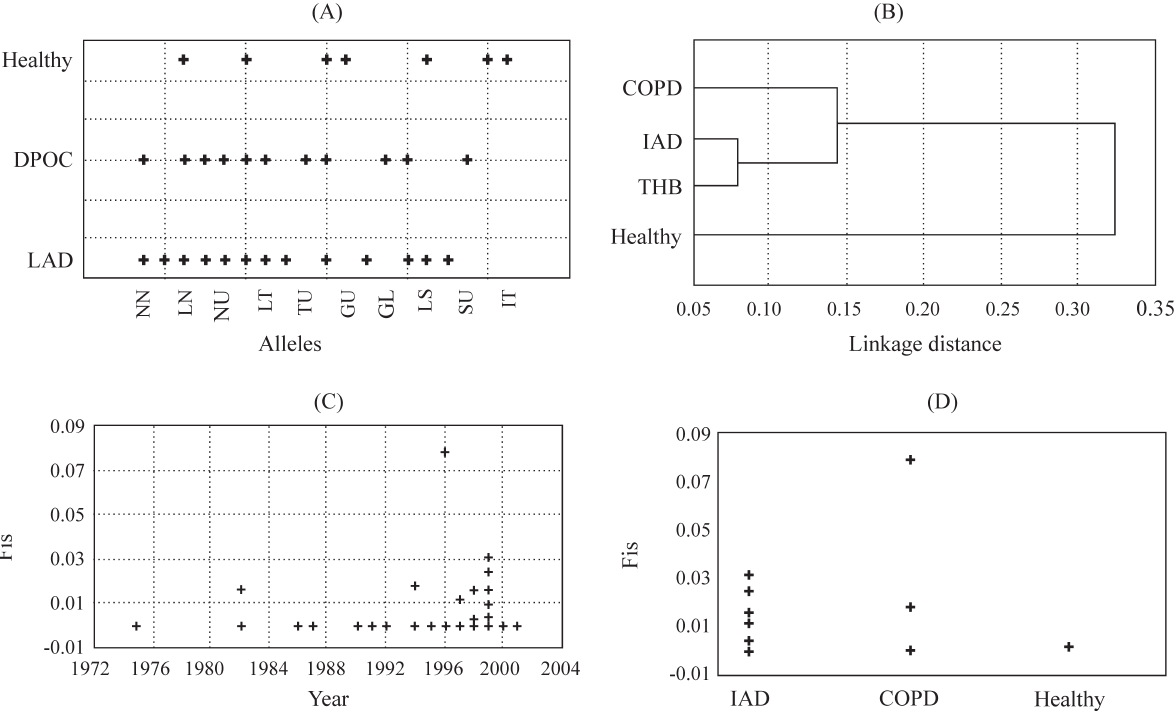
Figure 1 - (A) PI genotype distribution in thoroughbreds with chronic obstructive pulmonary disease (COPD), inflammatory airway disease (IAD) and healthy control horses (Healthy). (B) Tree diagram using PI allelic frequencies of horses with COPD, IAD, Healthy and a population of 3,600 thorough- breds(THBI).(C)Yearofbirthandinbreedingcoefficient(Fis)ofthe75thoroughbredhorseswithCOPD,IADandhealthyhorsesusedinthisstudy.(D) Fis of 75 thoroughbred horses with COPD, IAD and healthy